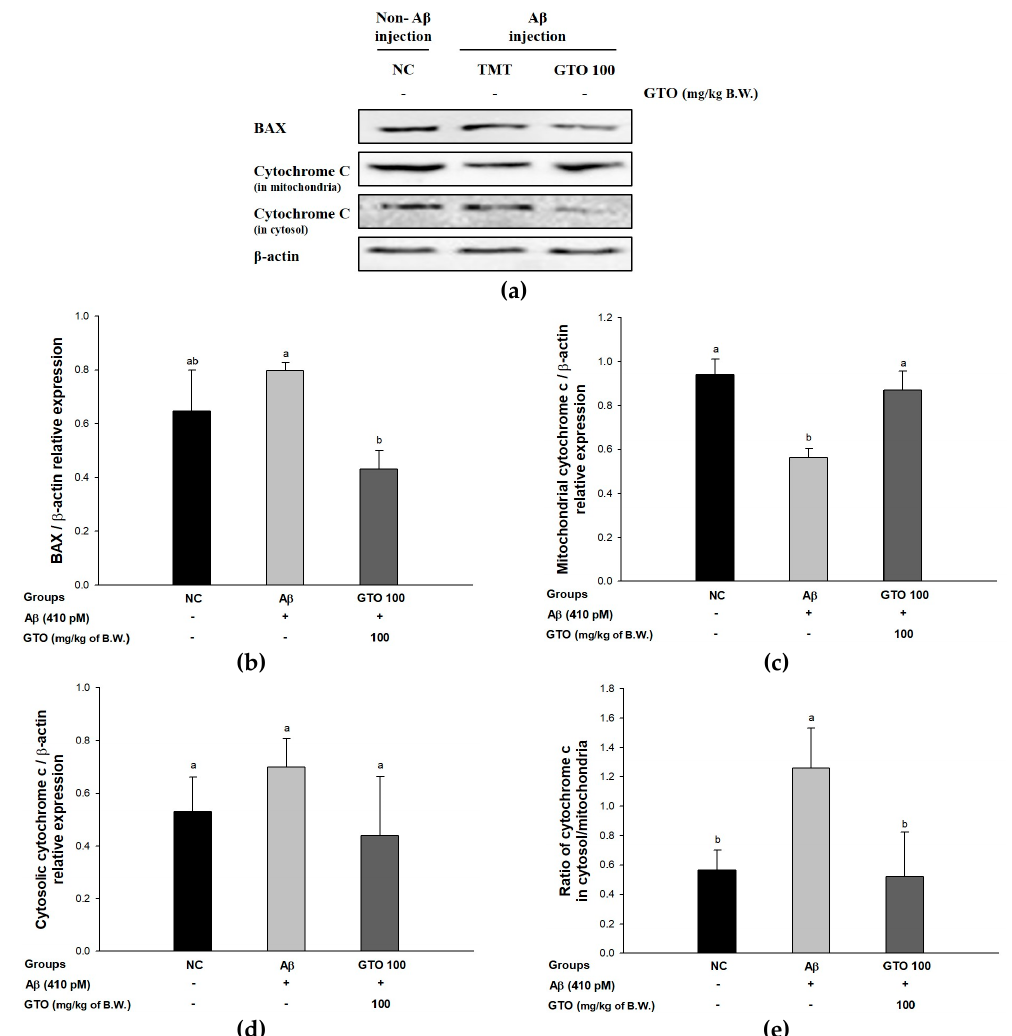
Figure 8. Ameliorating effect of green tea seed oil (GOT) on A β -related Akt/apoptosis pathway in mice brain tissues. ( a ) Representative Western blots for total protein and expression of BAX, mitochondrial cytochrome c, cytosolic cytochrome c and β -actin; The protein expression levels of BAX ( b ); mitochondrial cytochrome c ( c ); cytosolic cytochrome c ( d ); mitochondrial cytochrome c/cytosolic cytochrome c ratio ( e ) Results shown are mean ± SD ( n = 3). Data were statistically represented at p < 0.05, and different lowercase letters indicate statistical significance. NC: A β − /sample − group; A β : A β + /sample - group; GTO 100: A β + /GTO (100 mg/kg of body weight) + group. B.W.: body weight.